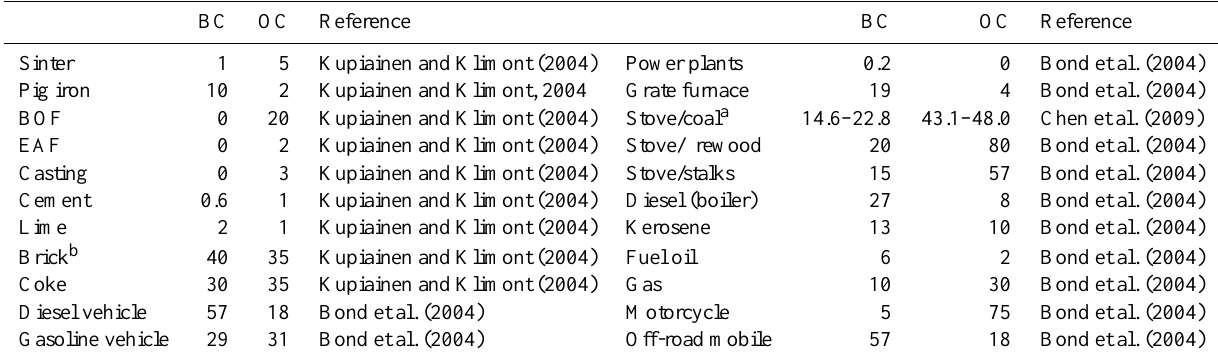
Table 6. Mass ratio of BC and OC to PM 2 . 5 from different emission sources, numbers show as percentage.